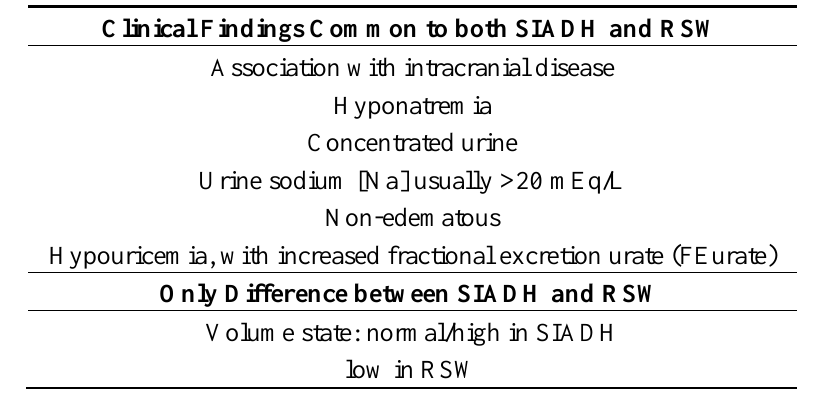
Table 1. List of features common to syndrome of inappropriate antidiuretic hormone secretion (SIADH) and renal salt wasting (RSW), except divergent volume status.